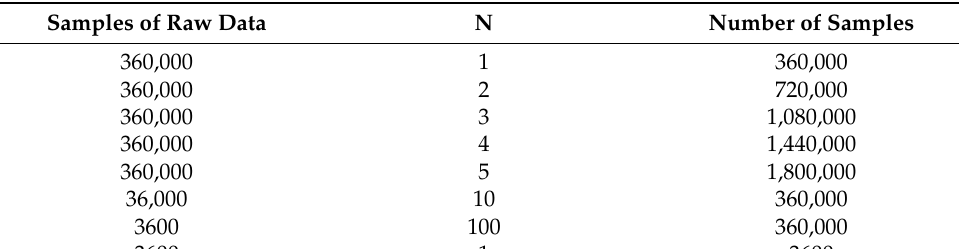
Table 2. Dataset relationship mapping table.